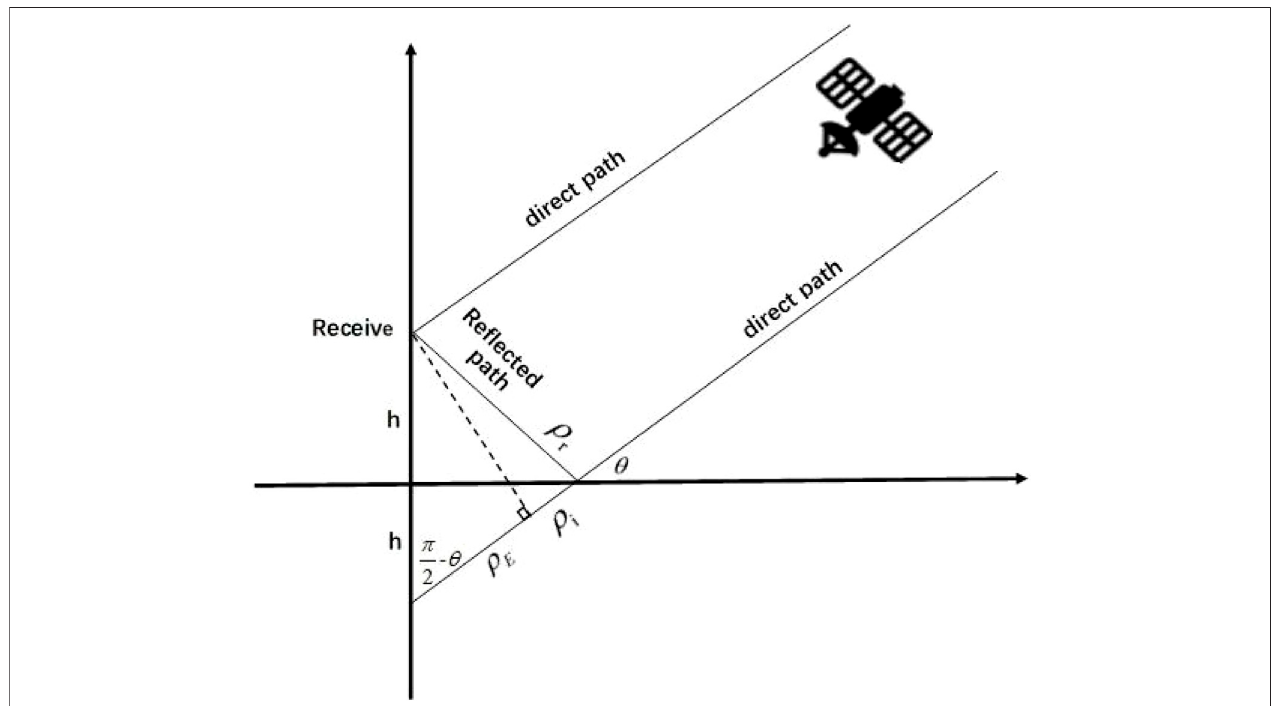
FIGURE 1 | Geometric path delay model of GNSS-R altimetry (Yang and Zhang, 2011).